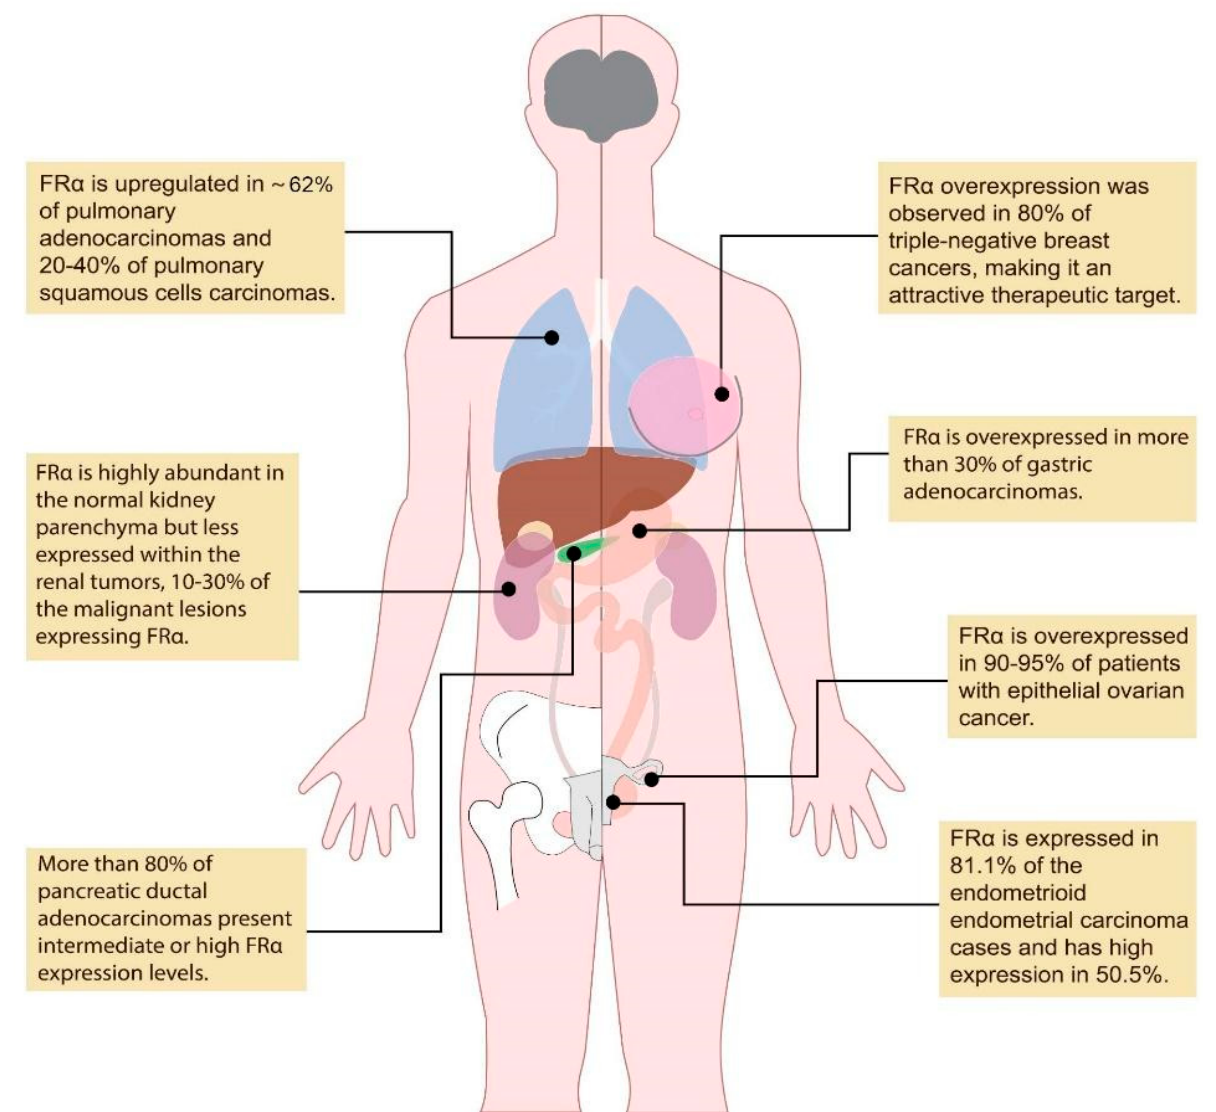
Figure 1. Overexpression of FR α in different types of malignancies. (created based on the information from references [11–22]).